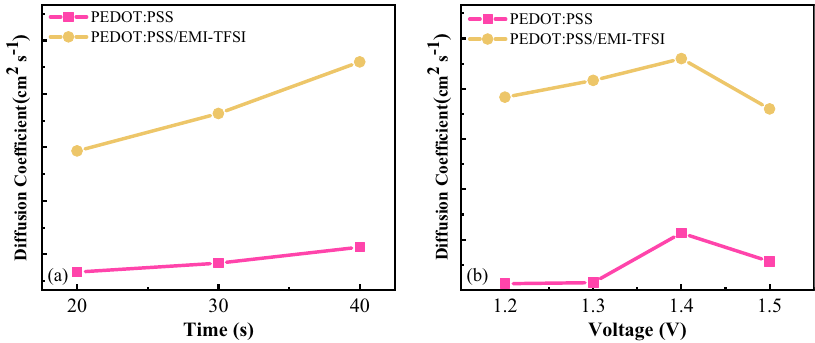
Figure 5: The ion di ff usion coe ffi cient at ( a ) di ff erent deposition times and ( b ) di ff erent